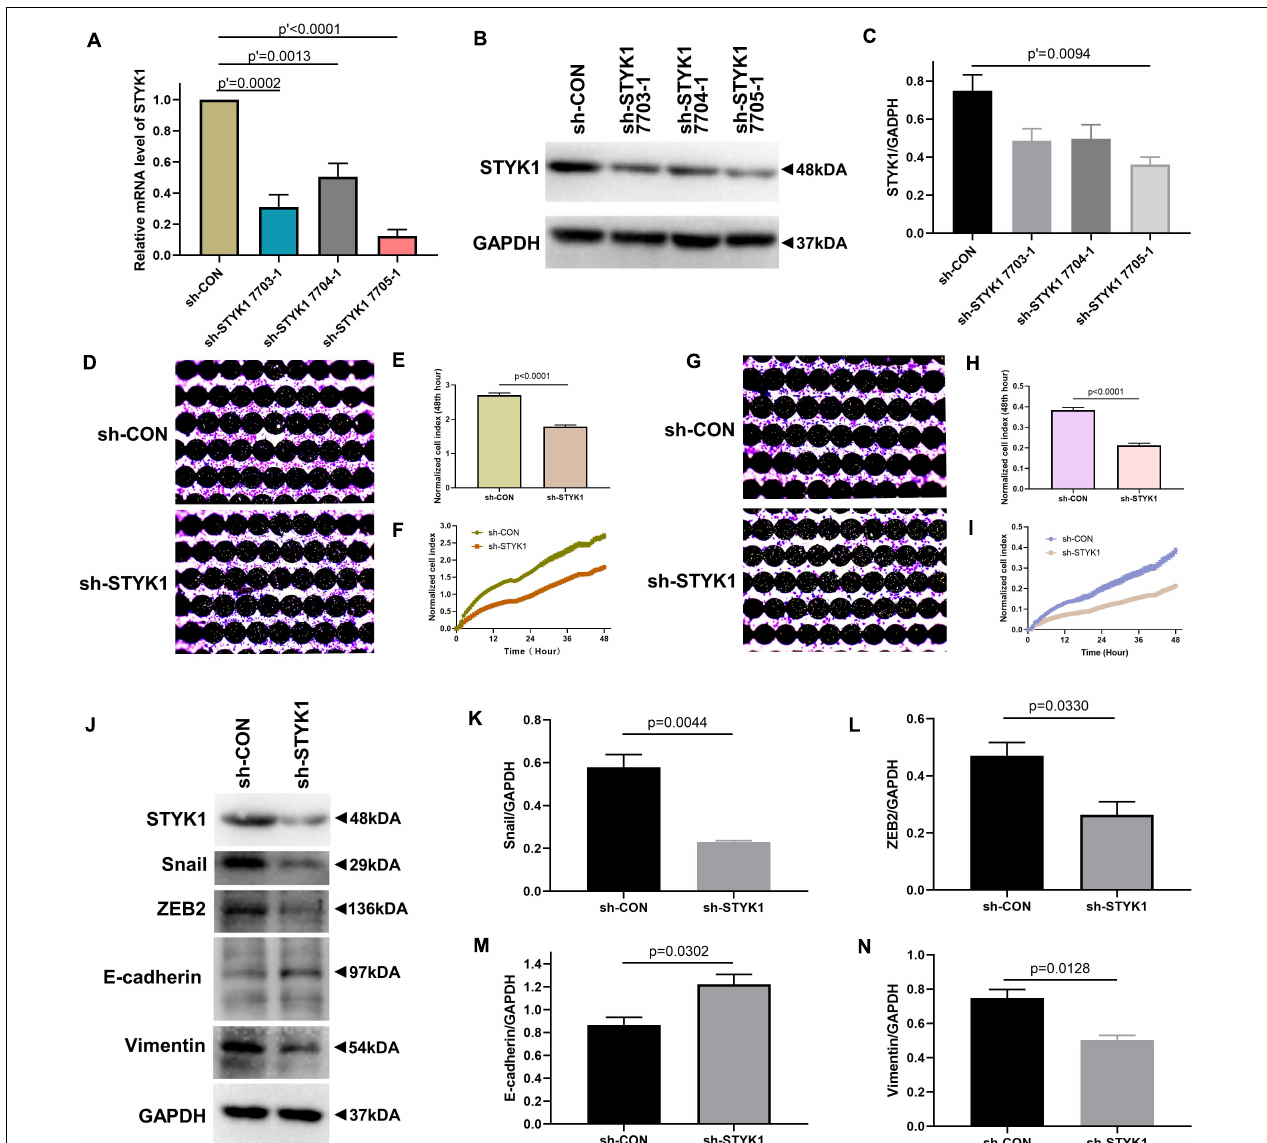
FIGURE 3 | Knockdown of STYK1 suppresses migration, invasion, and EMT in Calu-1 cells. (A–C) Transfection efficiency of STYK1 -targeting shRNAs in Calu-1 cells; sh-STYK1 7705-1 was adopted for further knockdown experiments. P (cid:48) < 0.0001, P (cid:48) = 0.0013, P (cid:48) = 0.0002 and P (cid:48) = 0.0094, ANOVA followed by the Dunnett’s multiple comparisons test. (D–F) Migration capacity of Calu-1 cells after shRNA transfection, evaluated by RTCA and crystal violet staining; P < 0.0001, Student’s t -test. (G–I) Invasion potential of Calu-1 cells after shRNA transfection; P < 0.0001, Student’s t -test. (J–N) Representative immunoblots and semiquantitative analysis of EMT biomarkers after shRNA transfection; P = 0.0044, P = 0.0330, P = 0.0302, and P = 0.0128, Student’s t -test. sh-CON, control Calu-1 cells; sh-STYK1, Calu-1 cells transfected with shRNA plasmids targeting STYK1